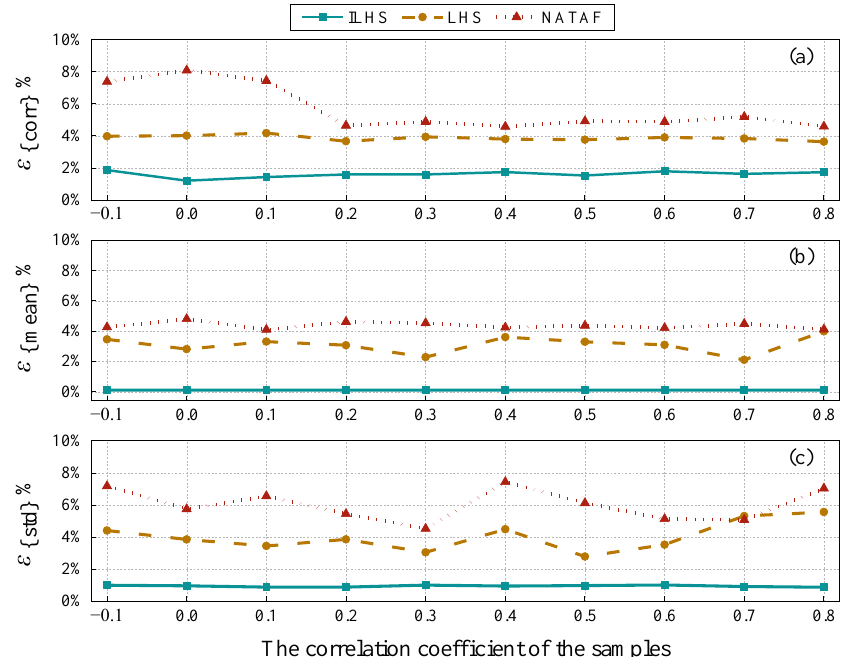
Table 1. The parameters of converter stations. Figure 5. The effect of samples with different correlation coefficients on the accuracy of algorithms: ( a ) the correlation coefficient error; ( b ) the mean error; and ( c ) the standard deviation error.